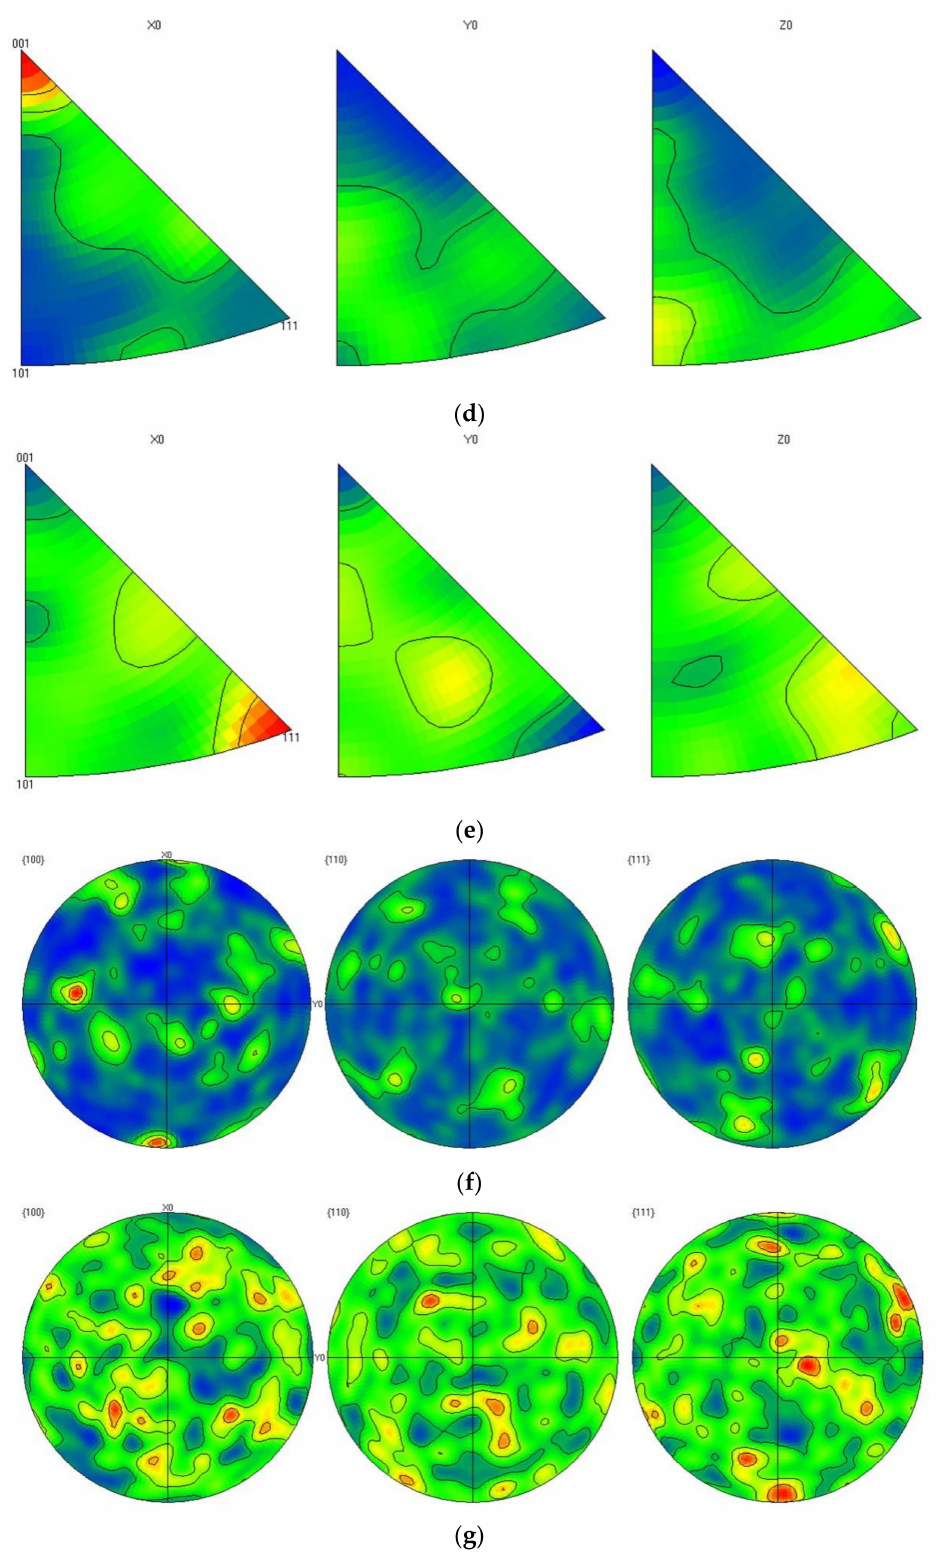
Figure 5. EBSD maps of non-heat-treated, die-cast samples before heat treatment: ( a ) X0